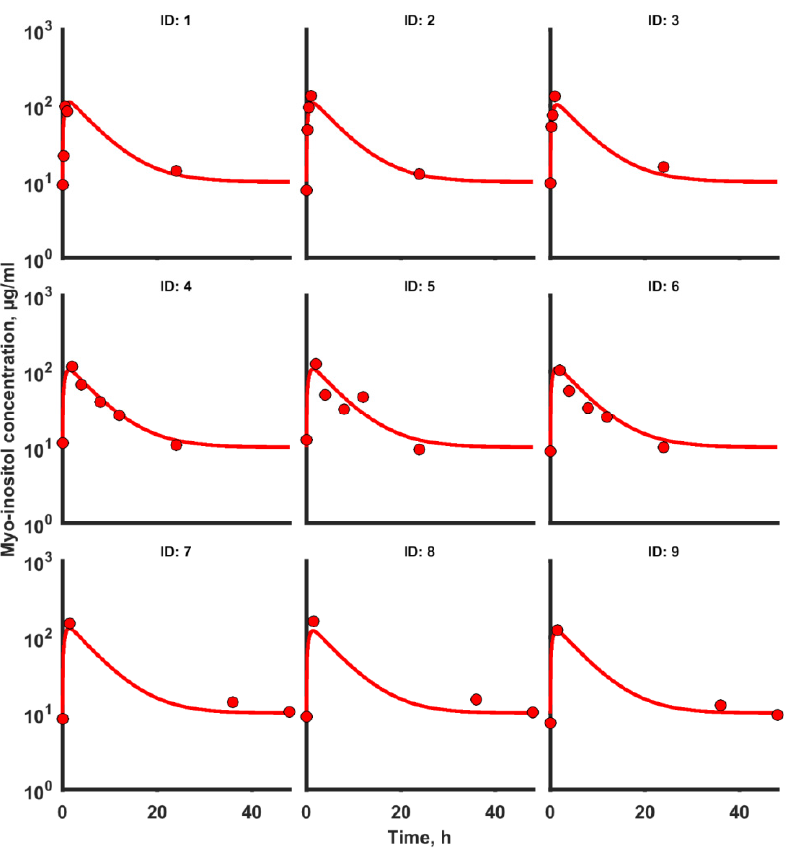
Figure 2. Plot of observed (circles) and individual predicted (solid lines) myo-inositol concentration–time profiles.